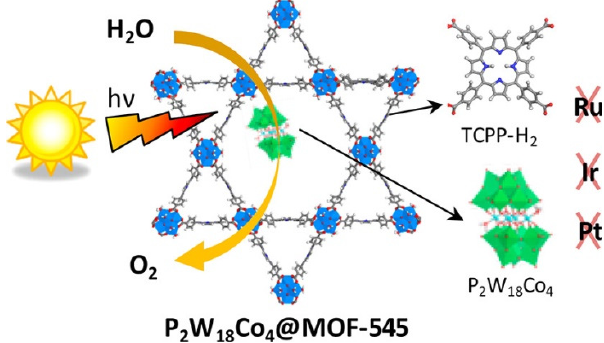
Figure 15. A fully noble metal-free POM@MOF catalyst for the photocatalytic oxidation of water. Reprinted with permission from [145]. Copyright (2018), American Chemistry Society.